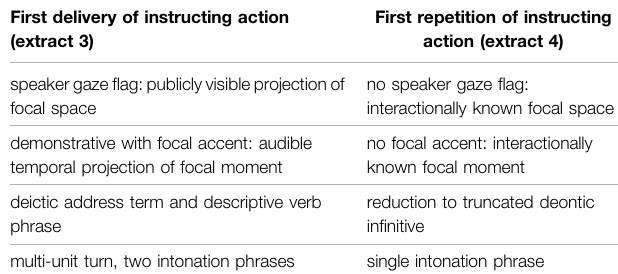
TABLE 1 | Summary of